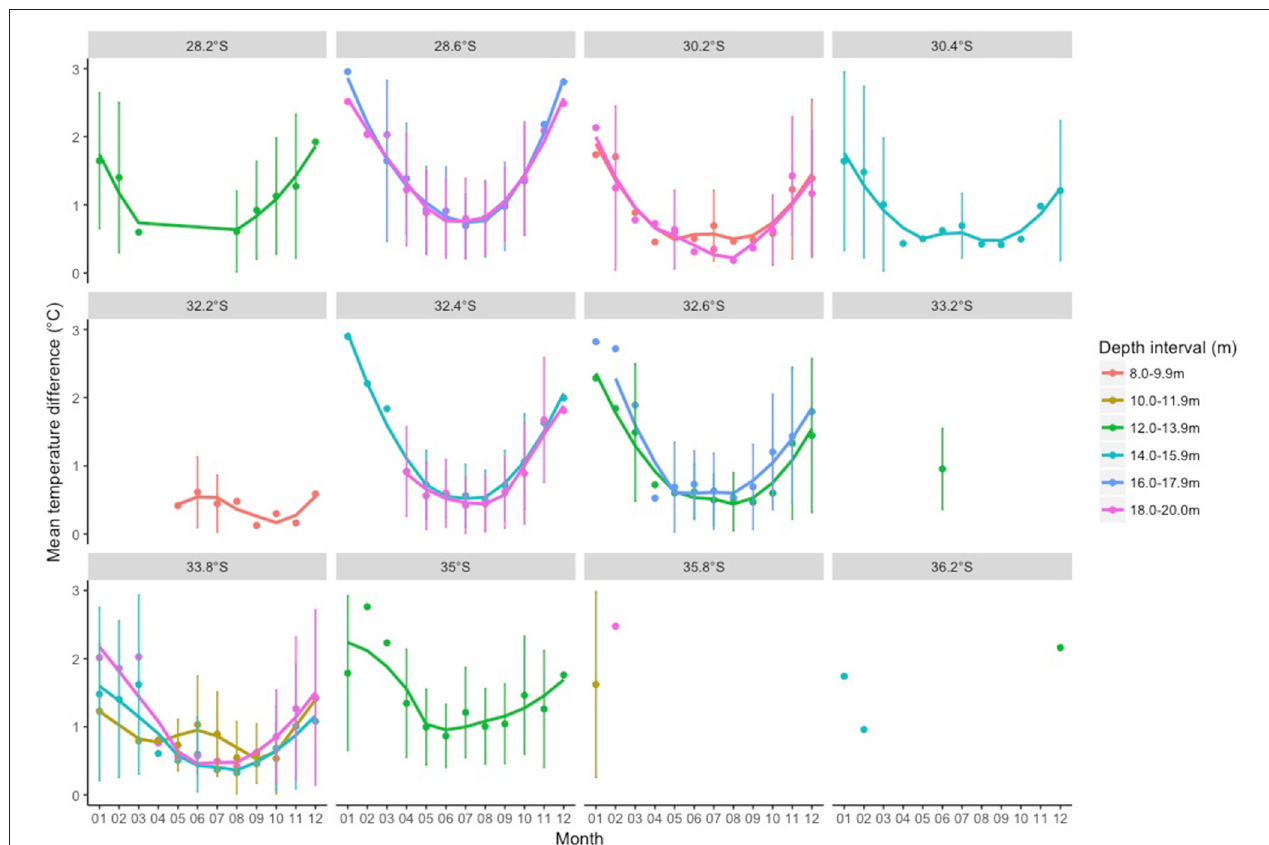
FIGURE 9 | Mean temperature differences between in situ and satellite that was processed at each logger location using an area average of 8km across shelf and 20km along shelf (i.e. area averaged values).